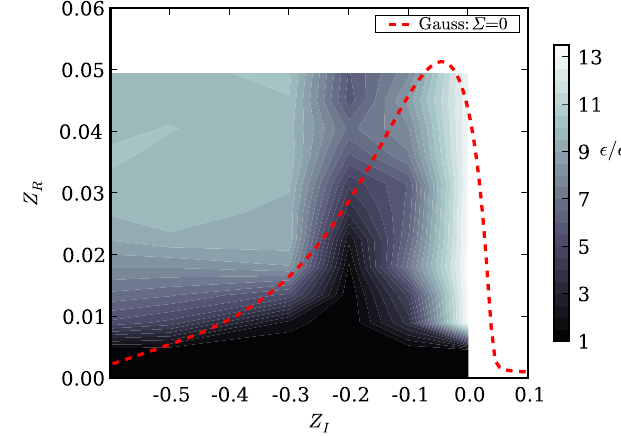
7. (Color) Simulation scan of the stability boundary in the normalized impedance plane for a single rf wave and (cid:1) (cid:7) 0 : 1 . The bunch length of the initially matched Gaussian distribution (cid:7) 60 (cid:12) . The red curves represent the stability boundaries is (cid:1) m obtained from the dispersion relation equation (28) for (cid:1) (cid:7) 0 (dashed curve) and (cid:1) (cid:7) 0 : 1 (solid curve).